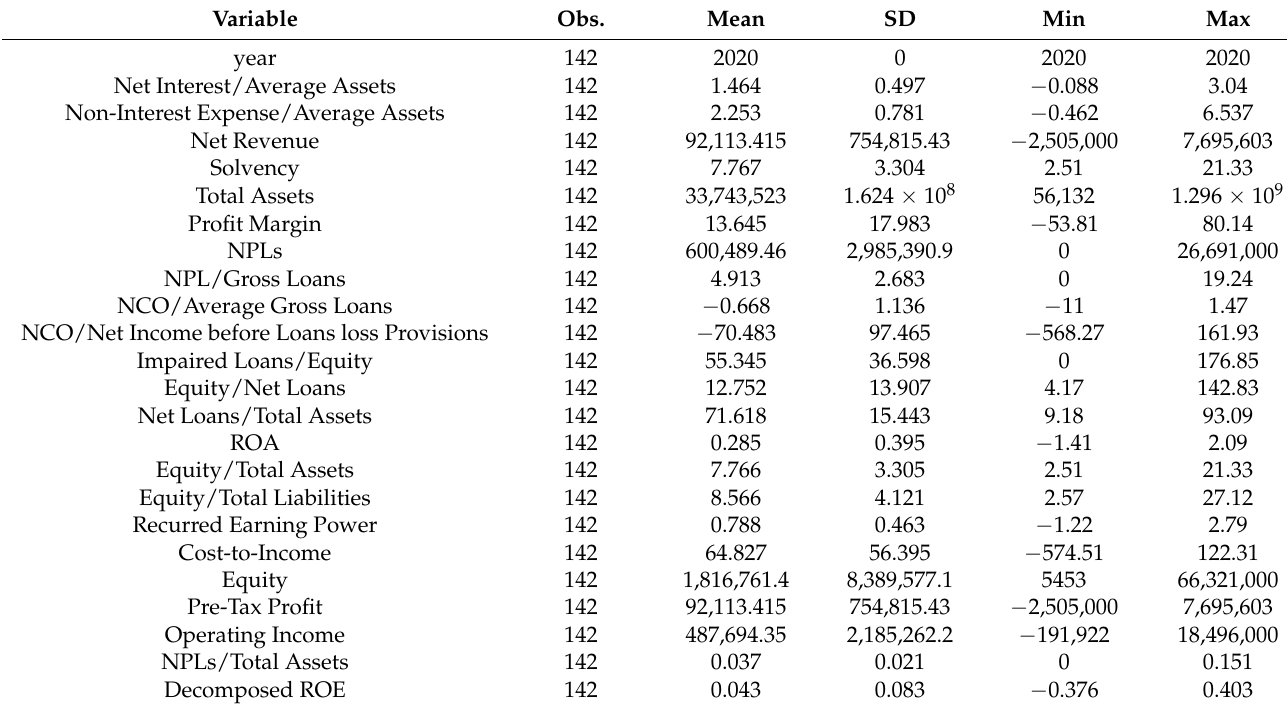
Table A10. Descriptive statistics for the 142 Italian banks for the year